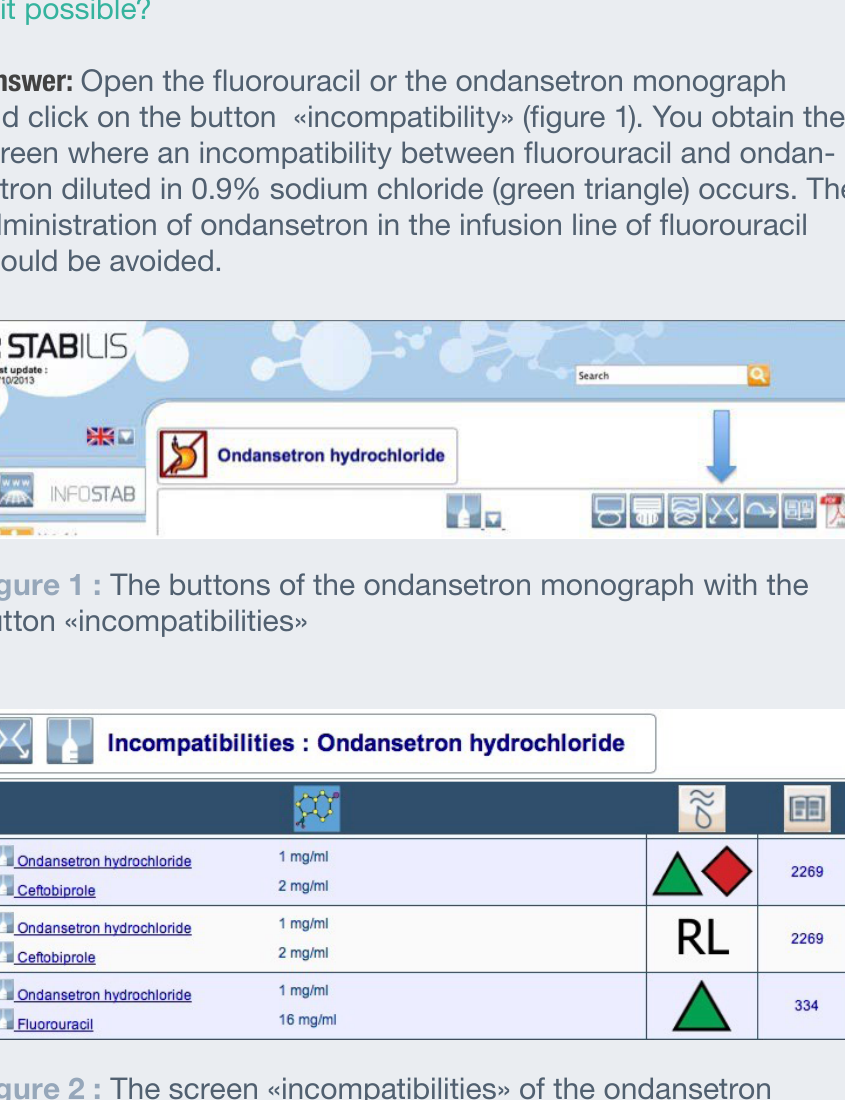
Figure 2 : The screen «incompatibilities» of the